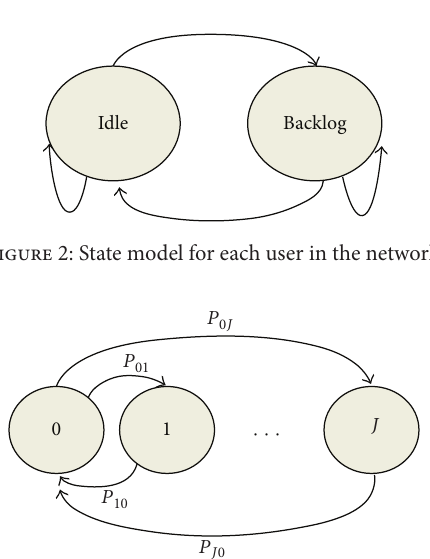
F 3: Network states and transition